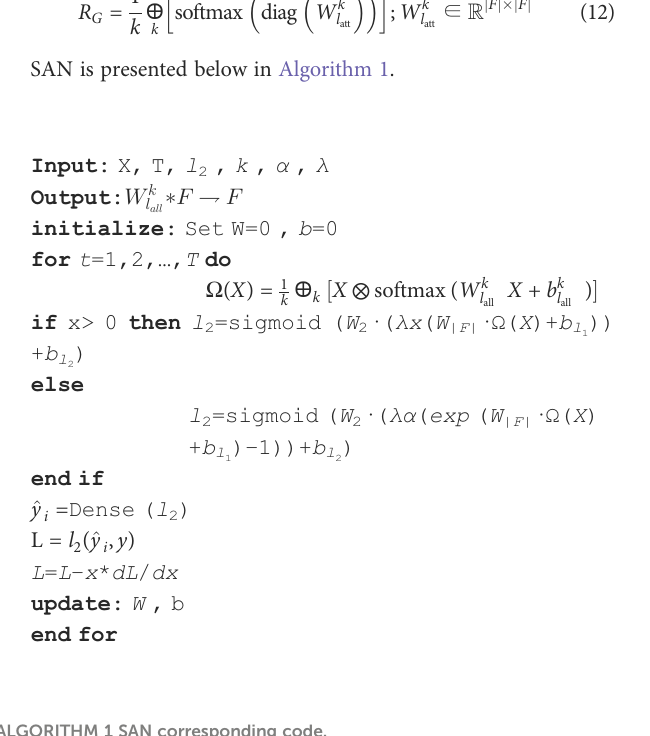
ALGORITHM 1 SAN corresponding code.